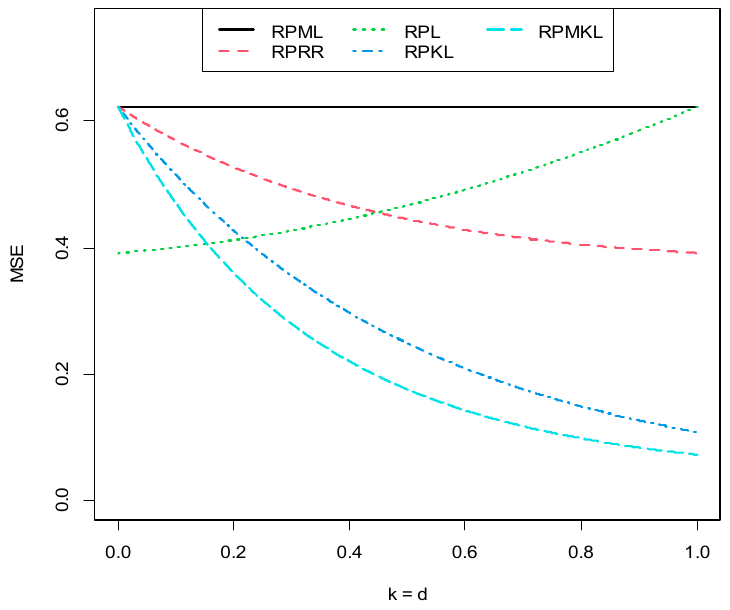
Figure 3. MSE values of the robust estimators against k and d of the aircraft damage data.